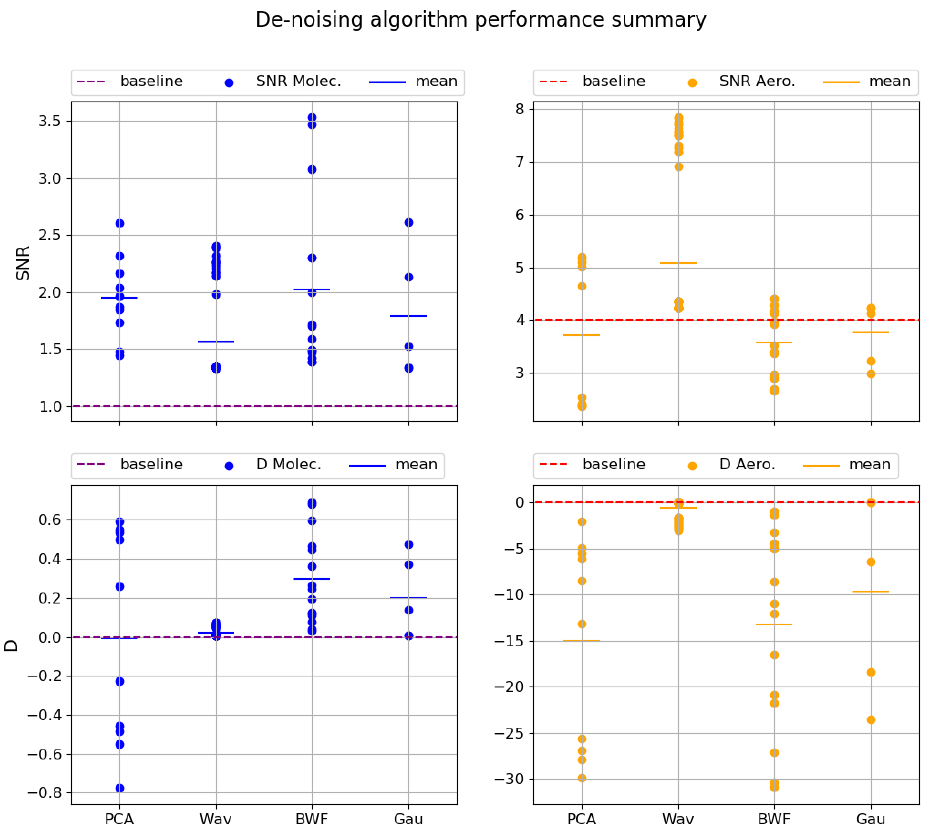
Figure 5. A comparison of denoising techniques on simulated photon-counting lidar data. The Signal-to-Noise Ratio (SNR) and Deviation (D) calculated for both molecular (blue) and aerosol (orange) signals for each test iteration(circle) with varying de-noising technique input parameters. The dashed line in each plot is the baseline value computed on the data before any